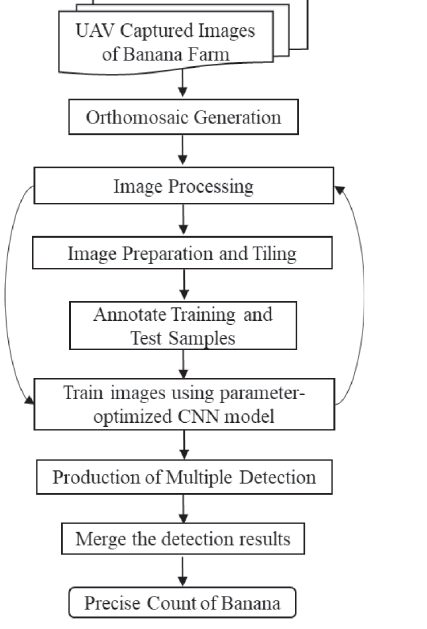
Fig 2. Workflow of proposed